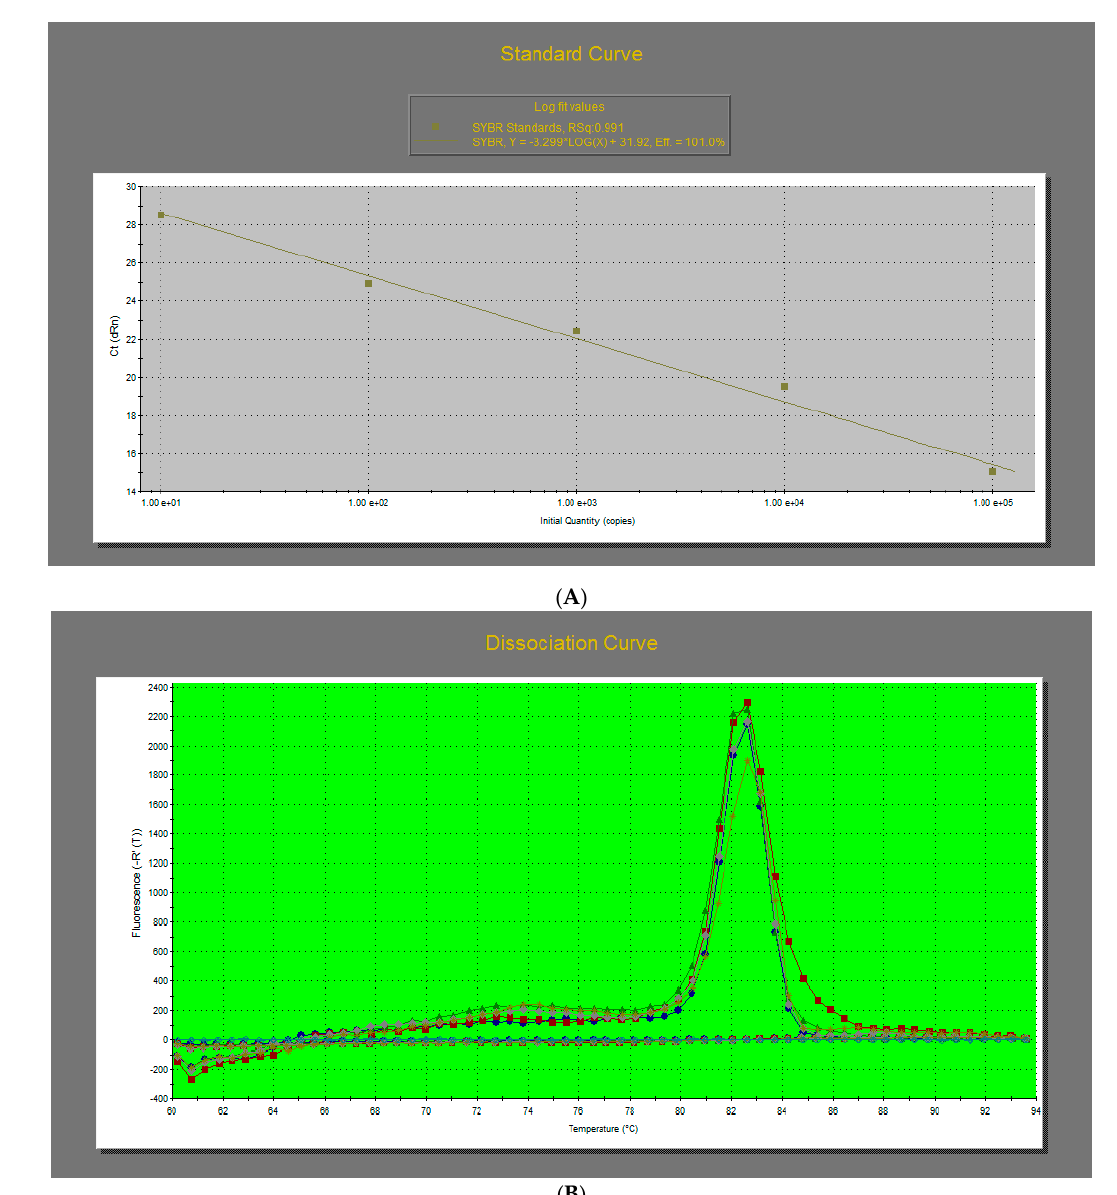
Figure 3. ( A ) Standard curve generated from the Mx3000P qPCR software based on virus copies from the plasmid BBTV-CP-pGEM-T Easy vector versus the number of cycles that were required to reach CT. The regression equation is CT= − 3.299 * log (number of virus copy) +31.92(‘*’ denotes multiplication sign). Amplification efficiency is 101.0% and the coefficient of determination (R 2 ) is greater than 0.99, which is acceptable. ( B ) Melt peak chart showing the melt profile for qPCR amplicons of the coat protein gene of BBTV from all test samples. The flat line indicates the negative control that failed to amplify